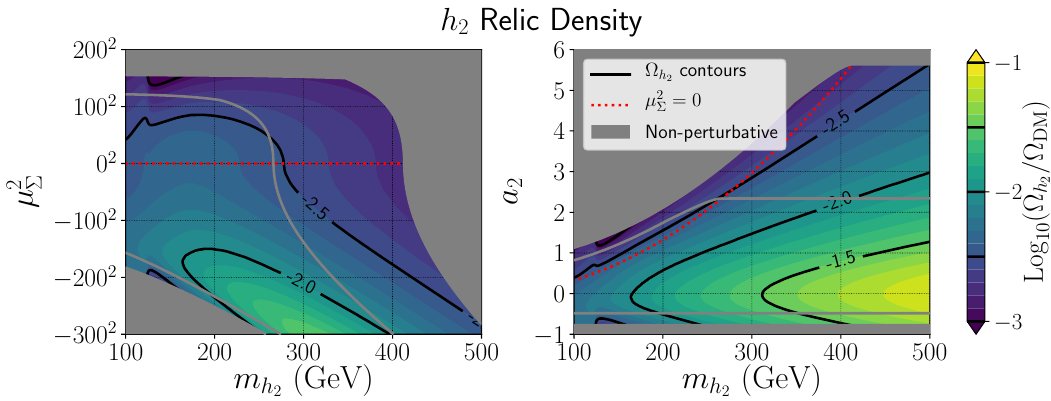
2 (left) or a 2 h 2 and either (cid:22) (cid:6) = m 2 ), such that the h 2 h 2 h 1 h 1 (cid:6) h 2 (cid:0) ! = 0 contour. (cid:6)